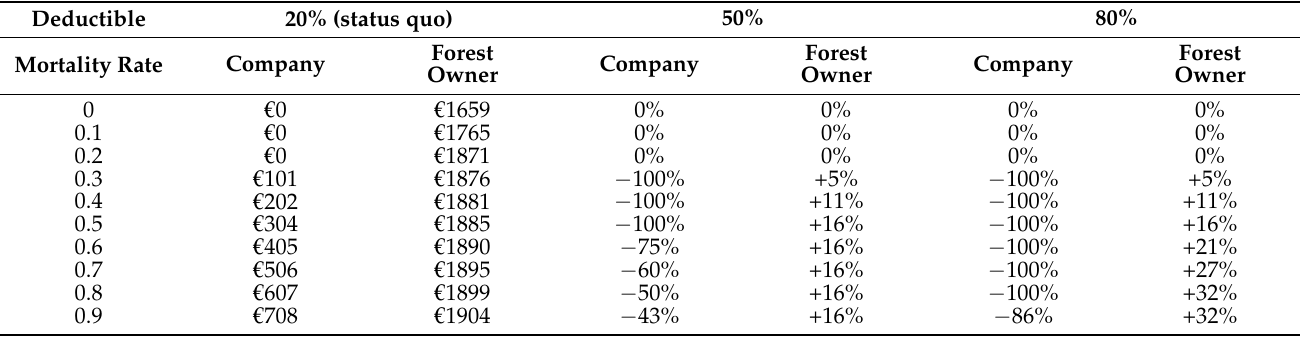
Table 6. Total discounted costs in EUR/ha for maritime pine ( Pinus pinaster Ait.) (itinerary “MP_CS- C”) for the forestry company and the forest owner for a deductible of 20% (current practice), 50%, and 80%. The costs are expressed (for different mortality rates) as variations in percentage of the total discounted costs with respect to the current practice (i.e., status quo).